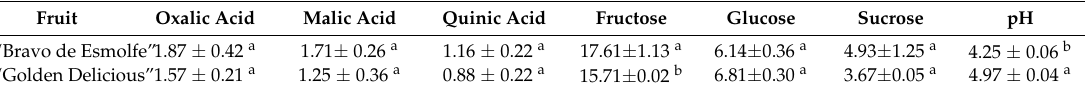
Table 1. Organic acid composition (g/100 g of dry weight), sugars (g/100 g of dry weight) and pH value.